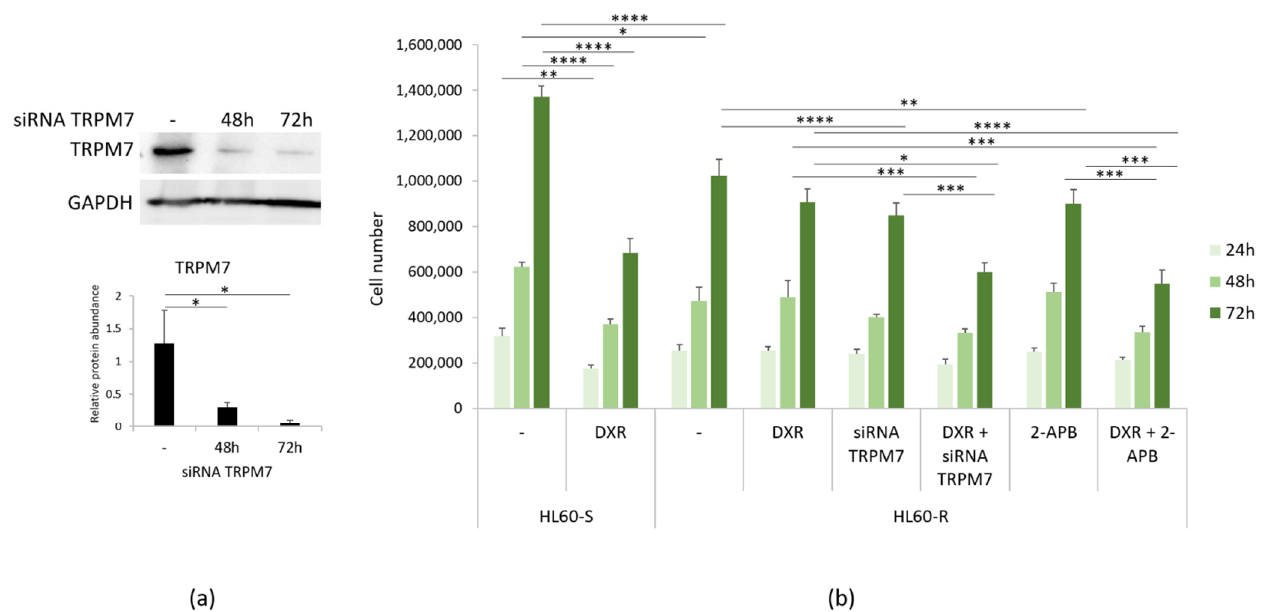
Figure 4. DXR cytotoxicity after inhibiting TRPM7. ( a ) HL60-R were transfected with a siRNA against TRPM7 for 48 and 72 h or with scrambled sequences as control (-). Western blot using antibodies against TRPM7 was performed on cell extracts as described in the methods. GAPDH was used as control of loading. A representative blot and densitometry obtained by ImageJ ± SD are shown. ( b ) HL60-R were silenced or treated with 2-APB (12.5 µ M) to inhibit TRPM7. The cells were then treated or not with DXR (10 µ g/mL). HL60-S treated or not with DXR were used as controls. The cells were counted after 24, 48 and 72 h. The experiment was performed three times in triplicate ± SD. * p < 0.05; ** p < 0.01; *** p < 0.001; **** p < 0.0001.